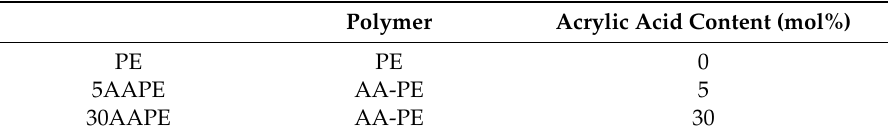
Table 1. Materials studied in the molecular dynamics (MD) simulations and nomenclature.